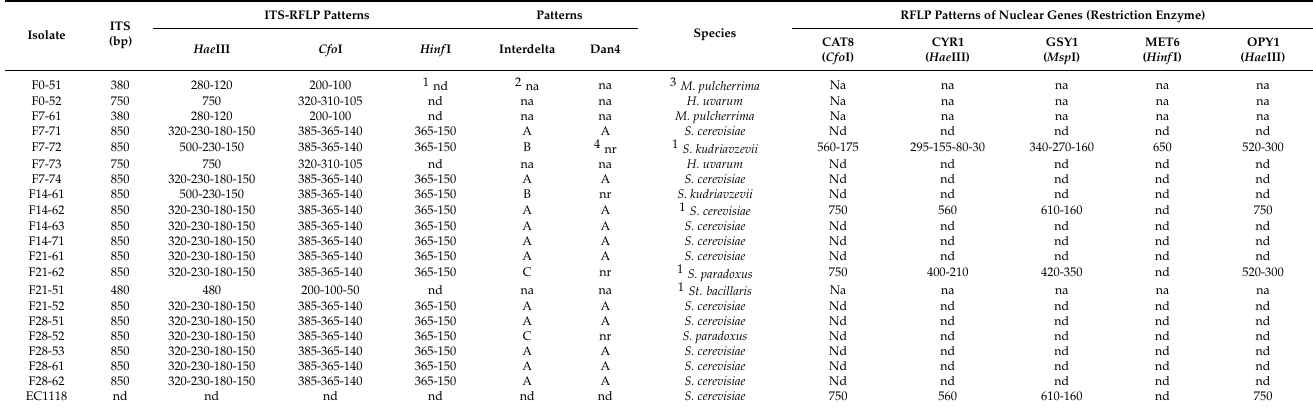
Table 2. ITS and ITS-RFLP patterns, identification, and typing of isolated yeasts.